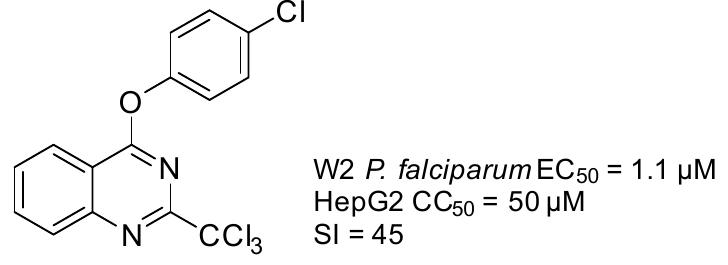
Figure 1. Previously described antiplasmodial Hit A.